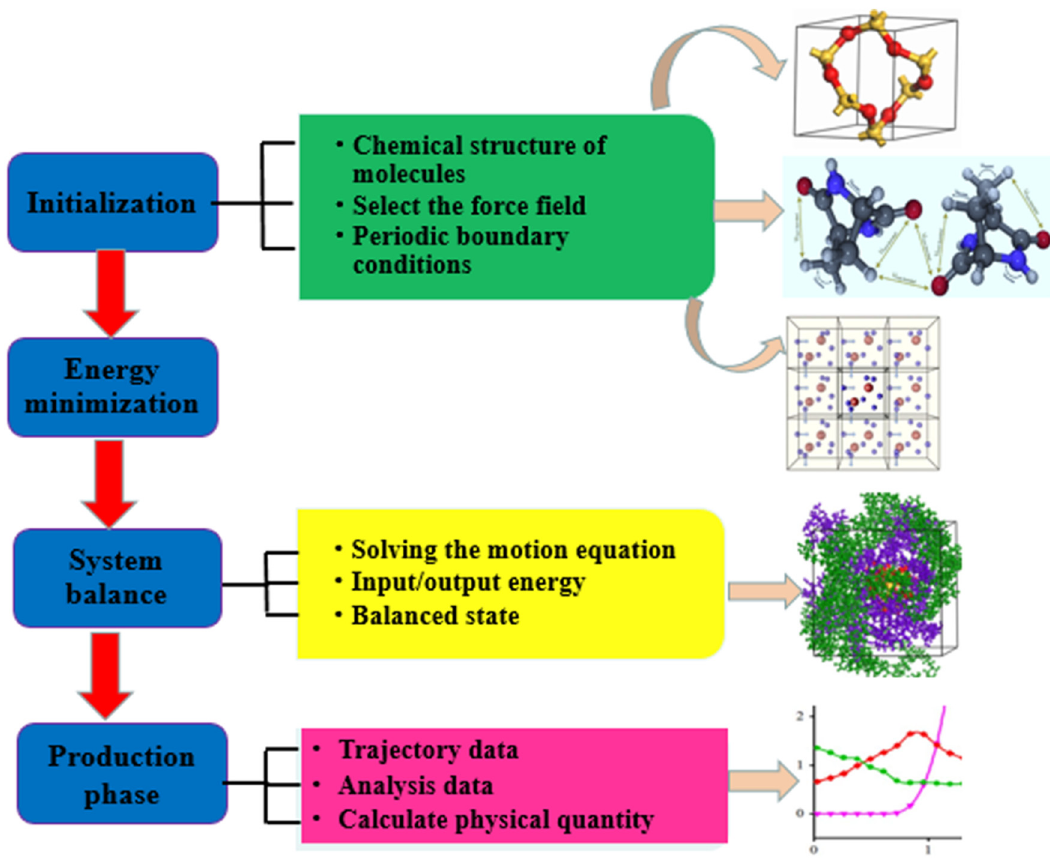
Figure 10: Schematic of the work fl ow of MD